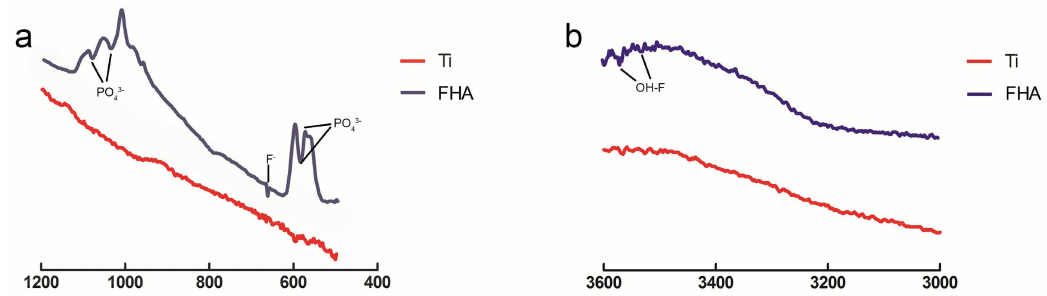
Figure 4. Fourier transform infrared spectra at ( a ) 1200–400 cm − 1 and ( b ) 3600–3000 cm − 1 .